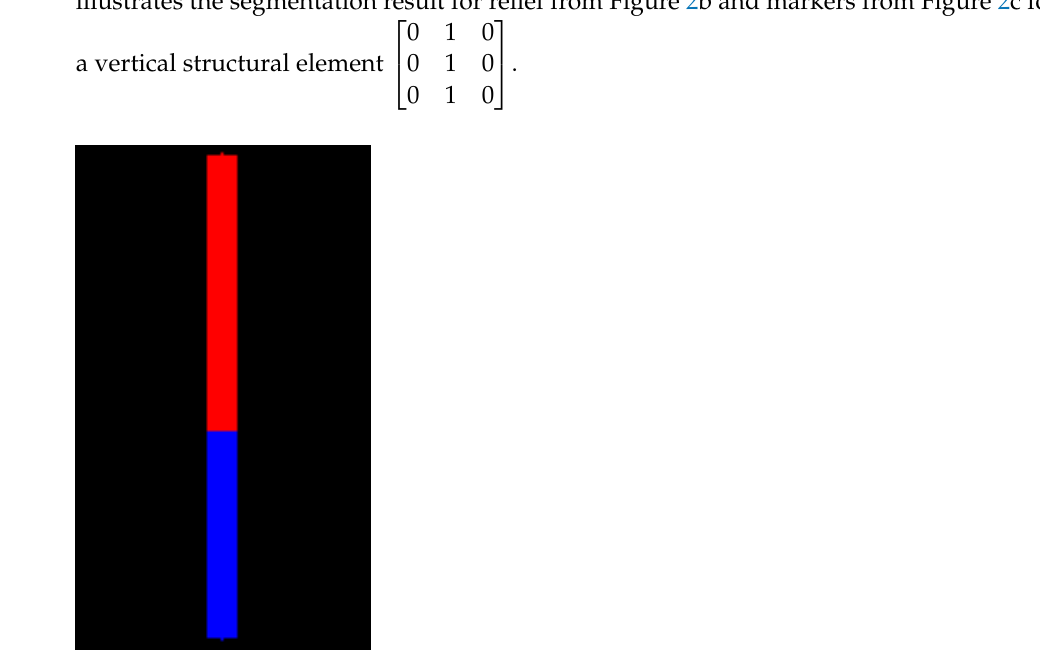
Figure 4. Result of watershed segmentation for relief from Figure 2b and markers from Figure 2c with 2-connectivity defined by vertical structural